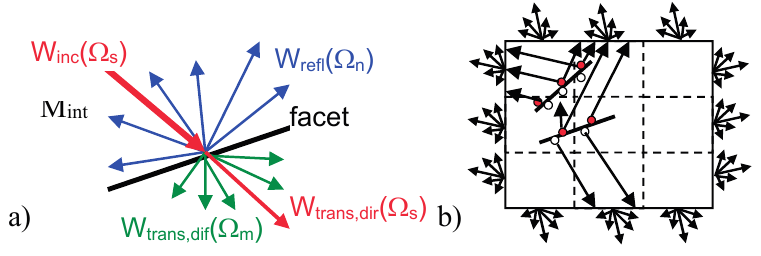
Figure 6. Facet scattering. ( a ) Single facet with an incident flux W inc (  s ). It